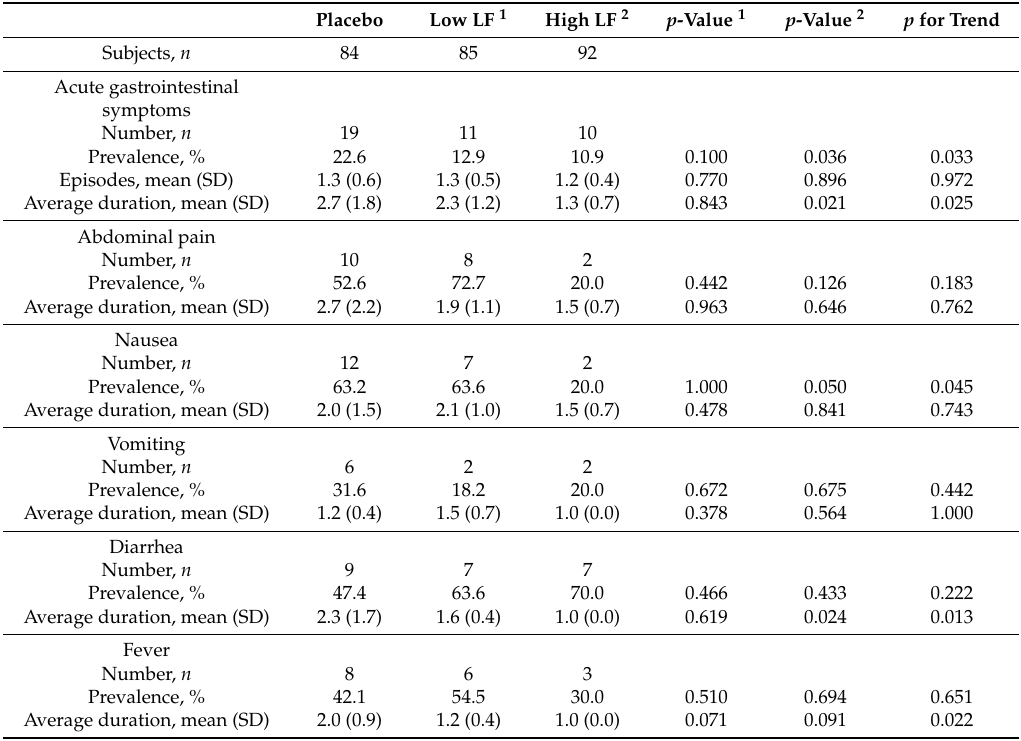
Table 3. Prevalence, episodes, and average duration of acute gastrointestinal symptoms (intake rate of ≥ 70%).